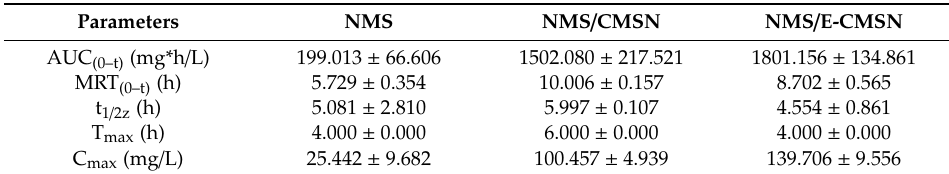
Figure 8. Plasma drug concentration profiles of NMS, NMS / CMSN, and NMS / E-CMSN (n = 3). Table 2. The pharmacokinetic parameters of NMS after oral administration of NMS, NMS / CMSN and NMS / E-CMSN (n =